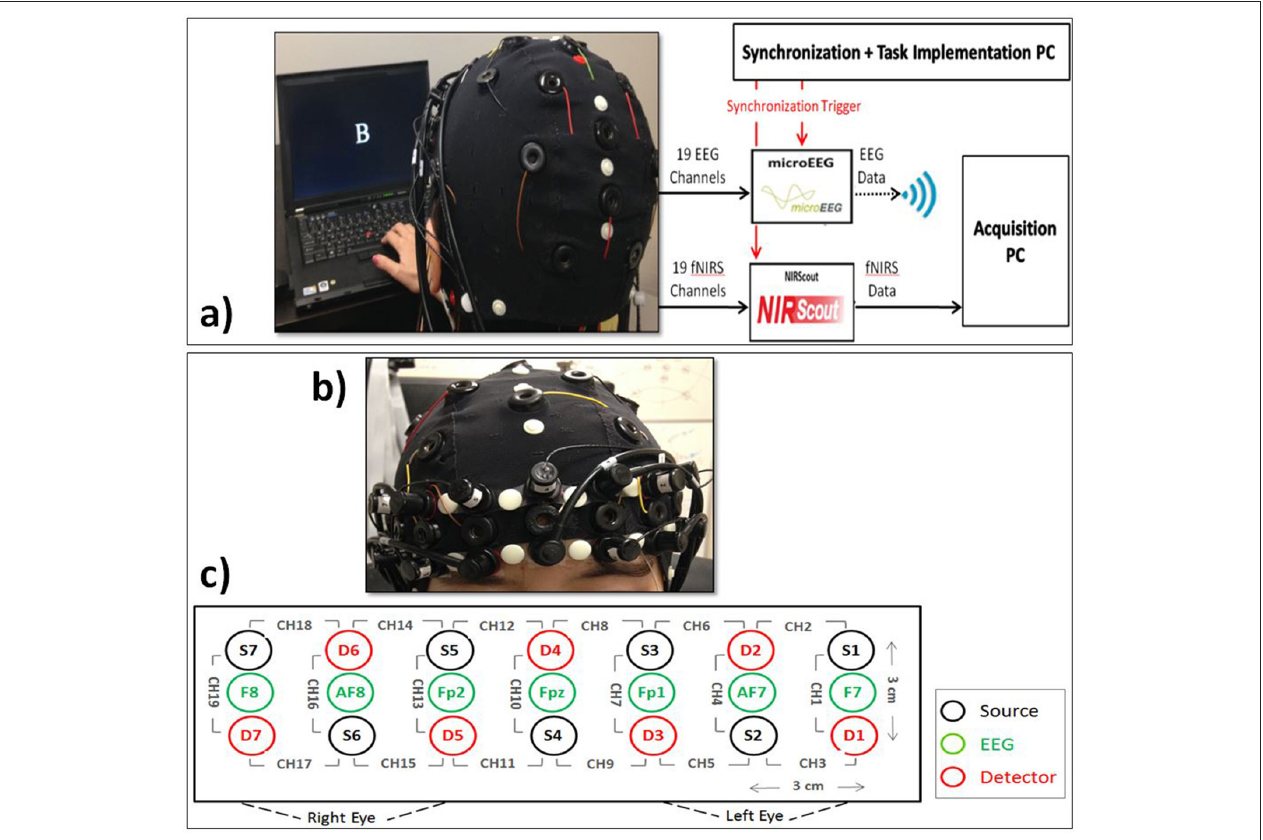
FIGURE 3 | (a) EEG + fNIRS recording setup. Subject interaction with the computer, synchronization of EEG and fNIRS signal, recording of EEG and fNIRS signals, and data transmission to the acquisition platform. (b) Coronal view of the subject showing the close view of the placement fNIRS optodes and EEG electrodes. (c) Topographical view of fNIRS sources (S i , black) and detectors (D i , red) and EEG electrodes (green). Each pair of source and detector separated by 3 cm creates a channel (CH i ). We used the signals from F7, Fpz, and